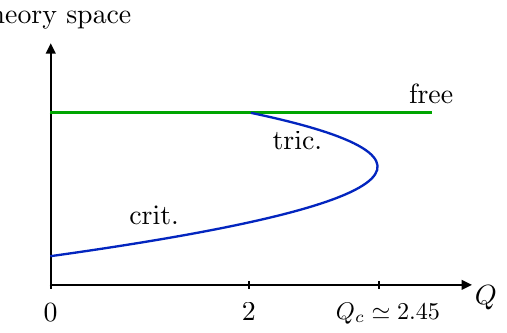
Figure 9 . Critical and tricritical Potts model for d = 3 as a function of Q > 0. The two (cid:12)xed points annihilate at Q 2 : 45. At Q = 2 the tricritical line intersects with the line of gaussian (cid:12)xed (cid:25) points (see the